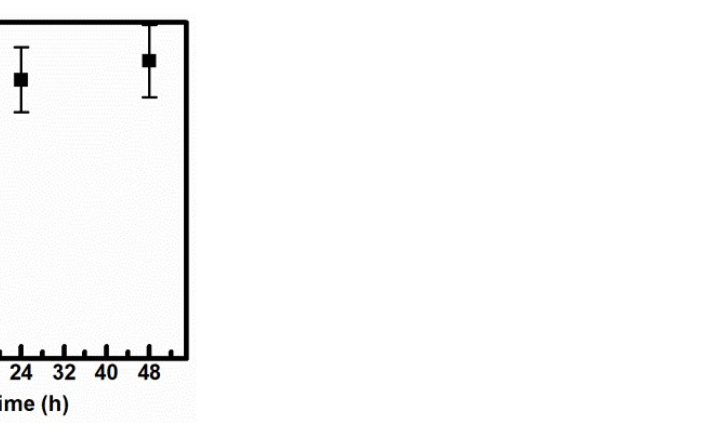
Figure 6. The cumulative drug release kinetic of INU-Cys-TC@SN38 in PBS pH 7.4 at 37